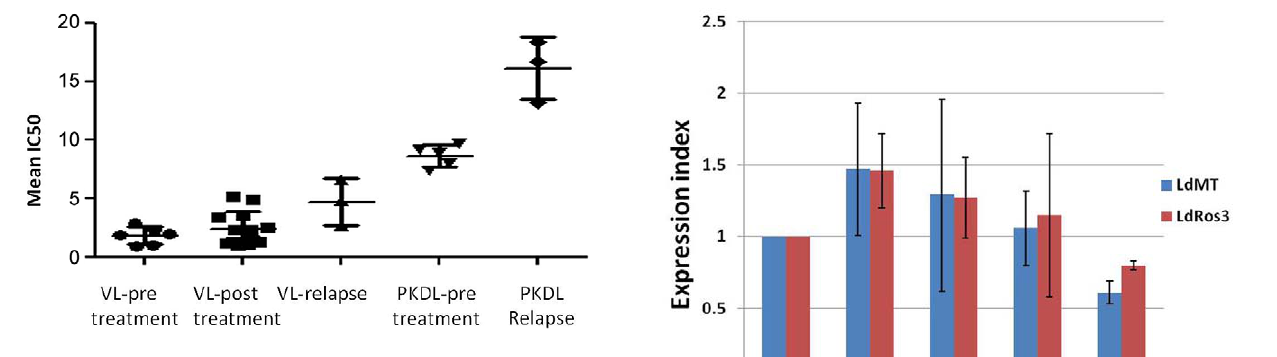
Figure 1. Invitro miltefosine susceptibility of parasite isolates from VL and PKDL cases before and after Mil treatment. Sensitivity of VL and PKDL isolates at intracellular amastigote stage were determined by infection in murine macrophage cell line J774A.1. Each individual value represents mean IC 50 6 SD of the results from two separate assays.